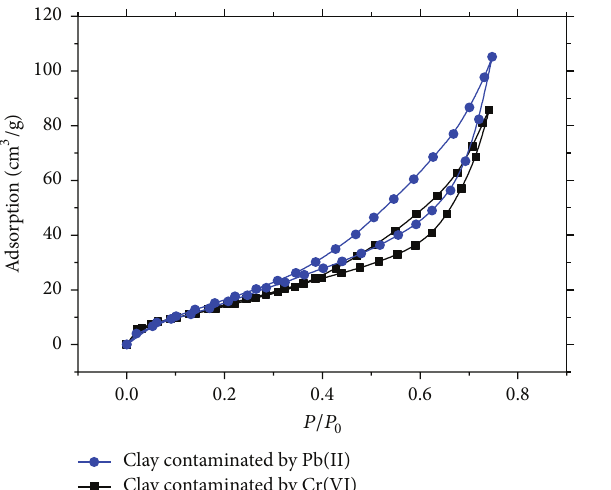
Figure 5: Adsorption and desorption isotherm of the samples.